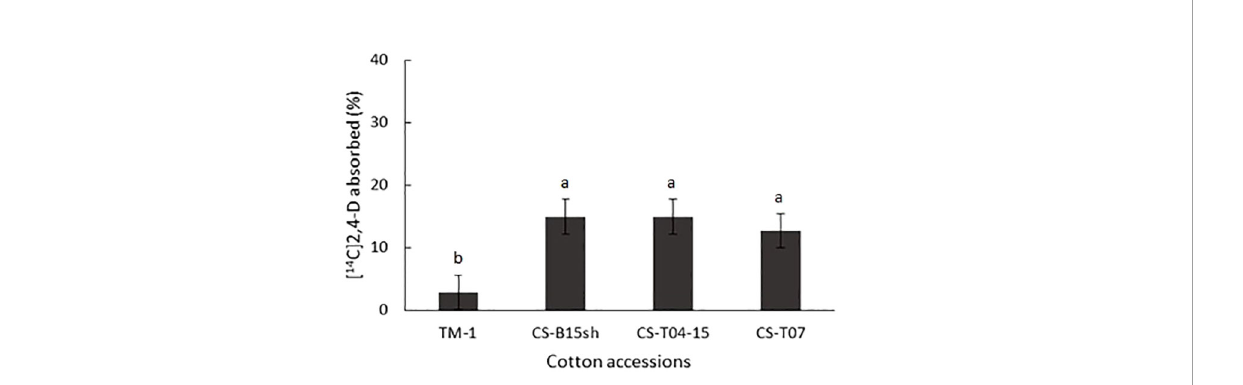
FIGURE 2 Percent absorption of [ 14 C]2,4-D on cotton seedlings of TM-1, CS-B15sh (31-4), CS-T04-15 (301-8), and CS-T07 (206-2) at 24 h after treatment (HAT). Means are separated with Tukey – Kramer HSD ( a = 0.05). Means of the same letter are not signi fi cantly